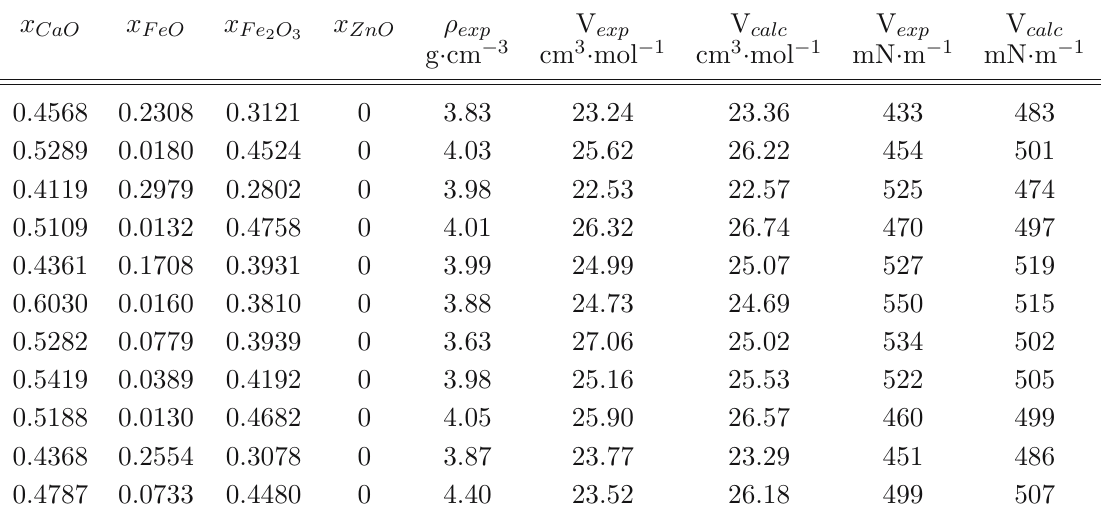
Table 2 Experimentally determined values of the density, molar volume and surface tension of the investigated melts of the system CaO-FeO-Fe 2 O 3 -ZnO at the temperature of 1573